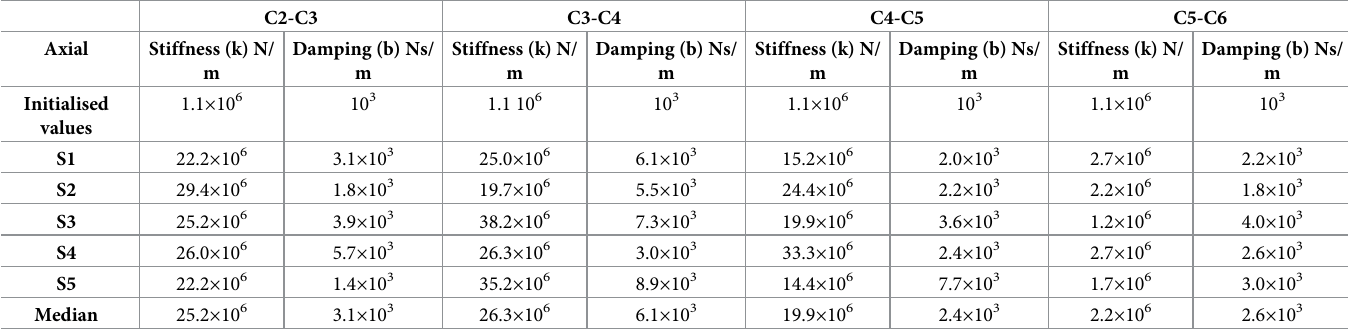
Table 2. Axial stiffness (k) and damping (b) parameter values identified for each specimen specific model of the spinal specimens (S1-S5).